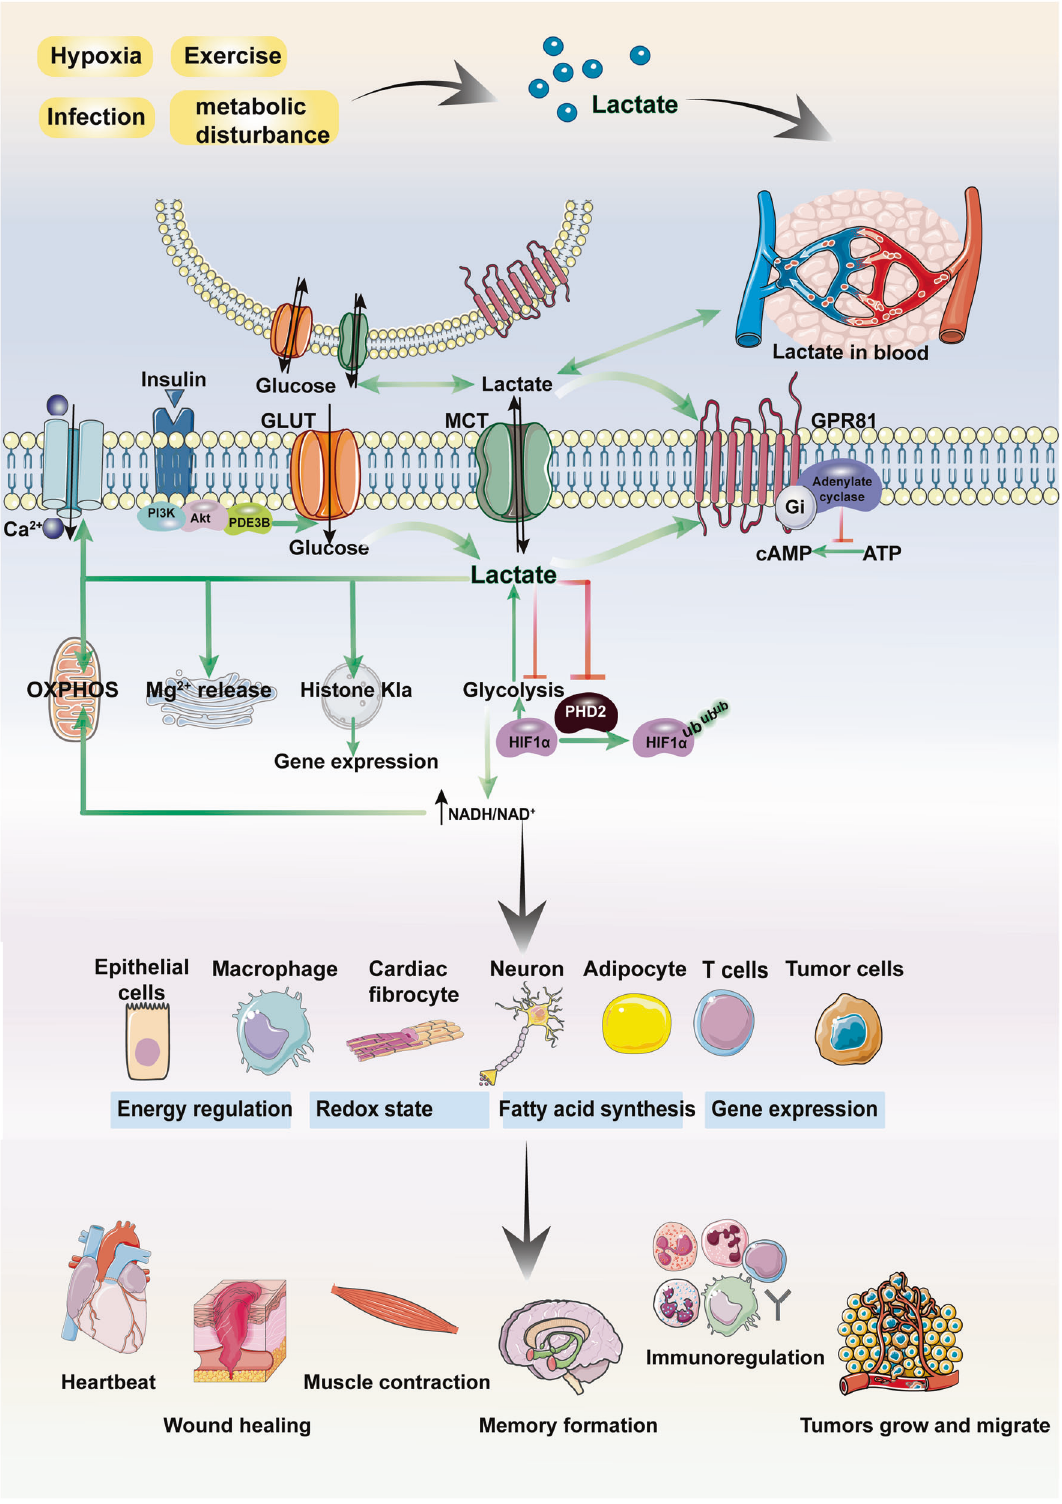
Fig. 2 Lactate is involved in the regulation of cellular physiological and pathological processes. In addition to the intracellular production of lactate, lactate can enter target cells through intercellular shuttling involving nonchannel pathways or MCT1. As a signaling molecule or metabolic substrate, lactate is involved in glucose metabolism, fatty acid synthesis, redox homeostasis, and the PTM of proteins. Meanwhile, as a GPR81 ligand, lactate stimulates the GPR81 signaling pathway. Lactate has been shown to regulate muscle contraction, wound healing, memory formation, and tumor development. MCT monocarboxylate transporter; OXPHOS oxidative phosphorylation; GLUT glucose transporter. (Figure was partly created with SMART – Servier Medical ART)